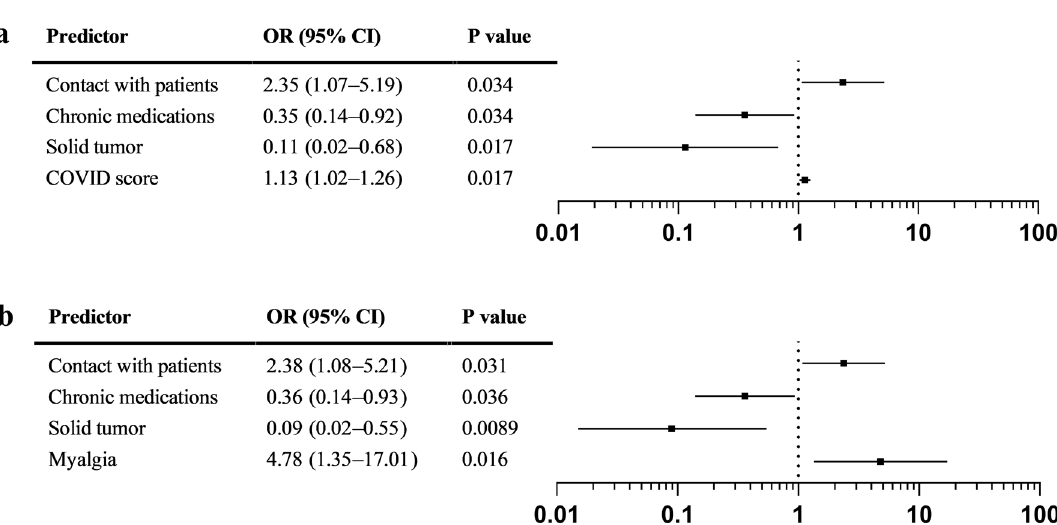
Figure 2. Predictors of persistent SARS-Cov-2 positive serology (IgG DiaSorin) in phase 4 in multivariate analyses. ( a ) Binary model with subject characteristics, exposure and COVID-19 score. ( b ) Binary model with subject characteristics, exposure and detailed